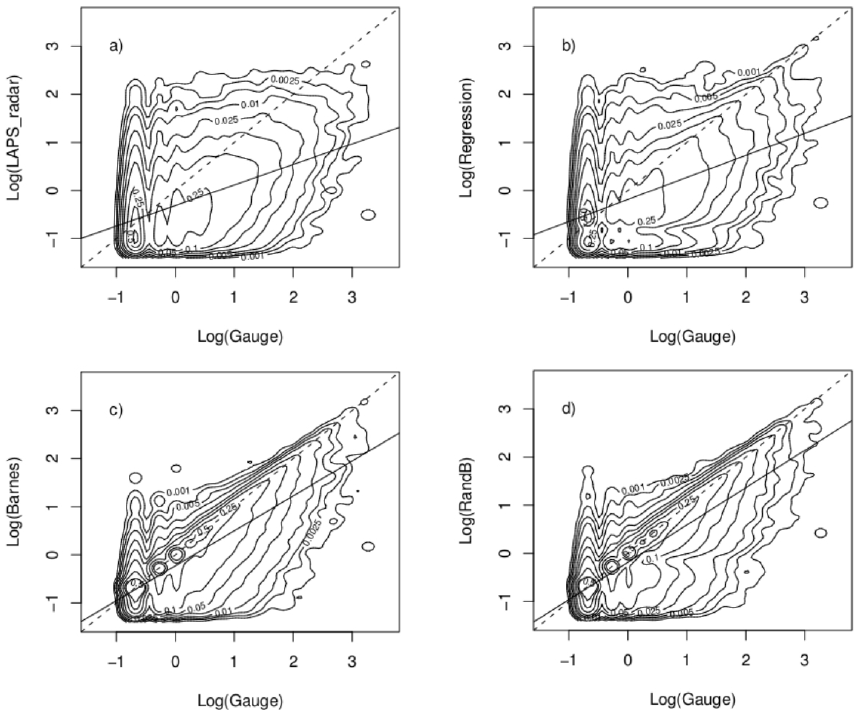
Fig. 2. Density plots of analyzed precipitation accumulation ( y axis) against observed rain-gauge values ( x axis) for the dependent stations: (a) LAPS_radar; (b) Regression; (c) Barnes, and (d) RandB. The continuous line is a linear fit to the data set and the dashed line represents the perfect 1:1 fit in the plots.